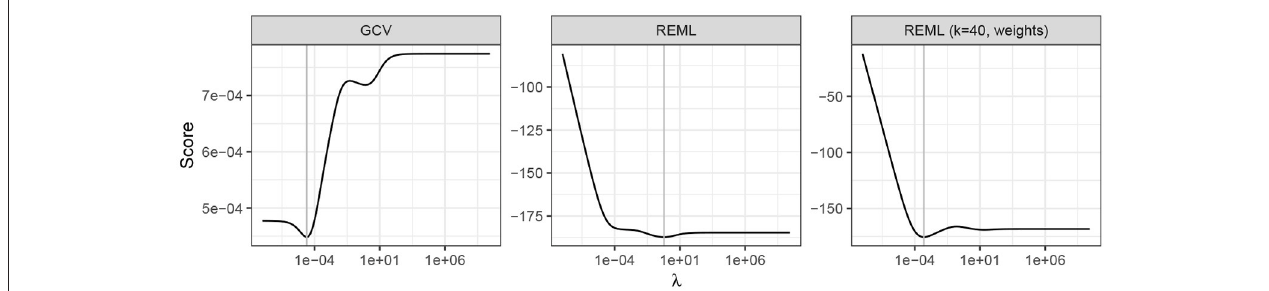
FIGURE 7 | GCV and REML scores as a function of the smoothness parameter λ . From left to right, GAMs were estimated using GCV and REML smoothness selection, and REML using a basis dimension of 40 and observational weights to account for heterogeneity in the U K 37 times series. The selected value of λ for each model is indicated by the vertical grey